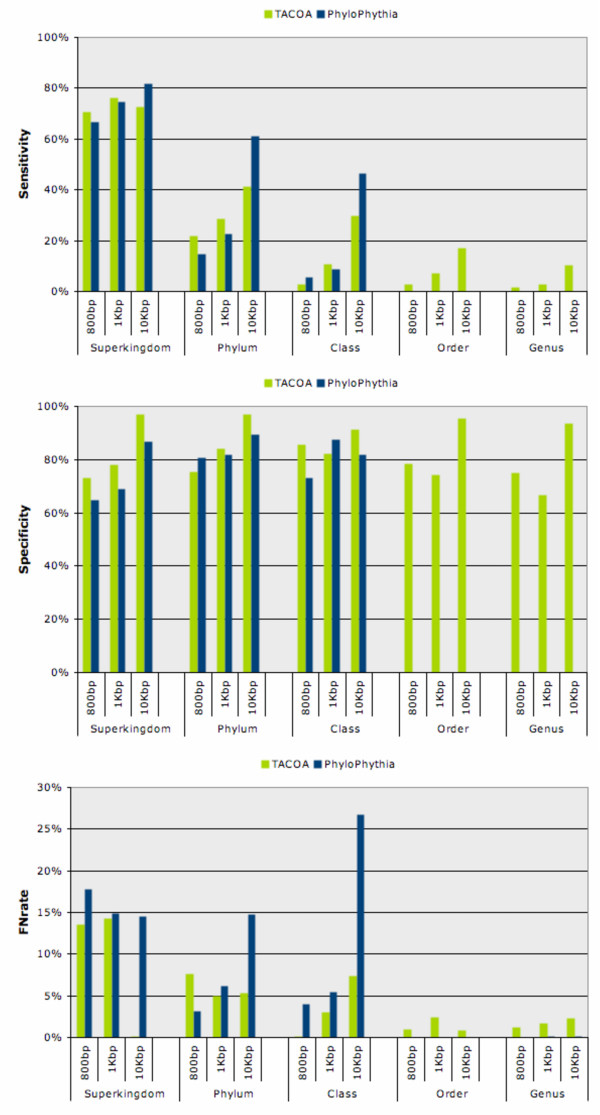
Classification accuracy obtained for TACOA and PhyloPythia. Sensitivity (top), specificity (middle) and false negative rate (bottom) achieved by TACOA and PhyloPythia for three different genomic fragment lengths and taxonomic ranks evaluated. Single read lengths are represented by fragments of length 800 bp and 1 Kbp and contigs by 10 Kbp long fragments. The accuracy achieved is depicted using green bars for TACOA and blue bars for PhyloPythia. The sensitivity and specificity charts are scaled between 0–100% and the false negative rate is scaled between 0–30%.